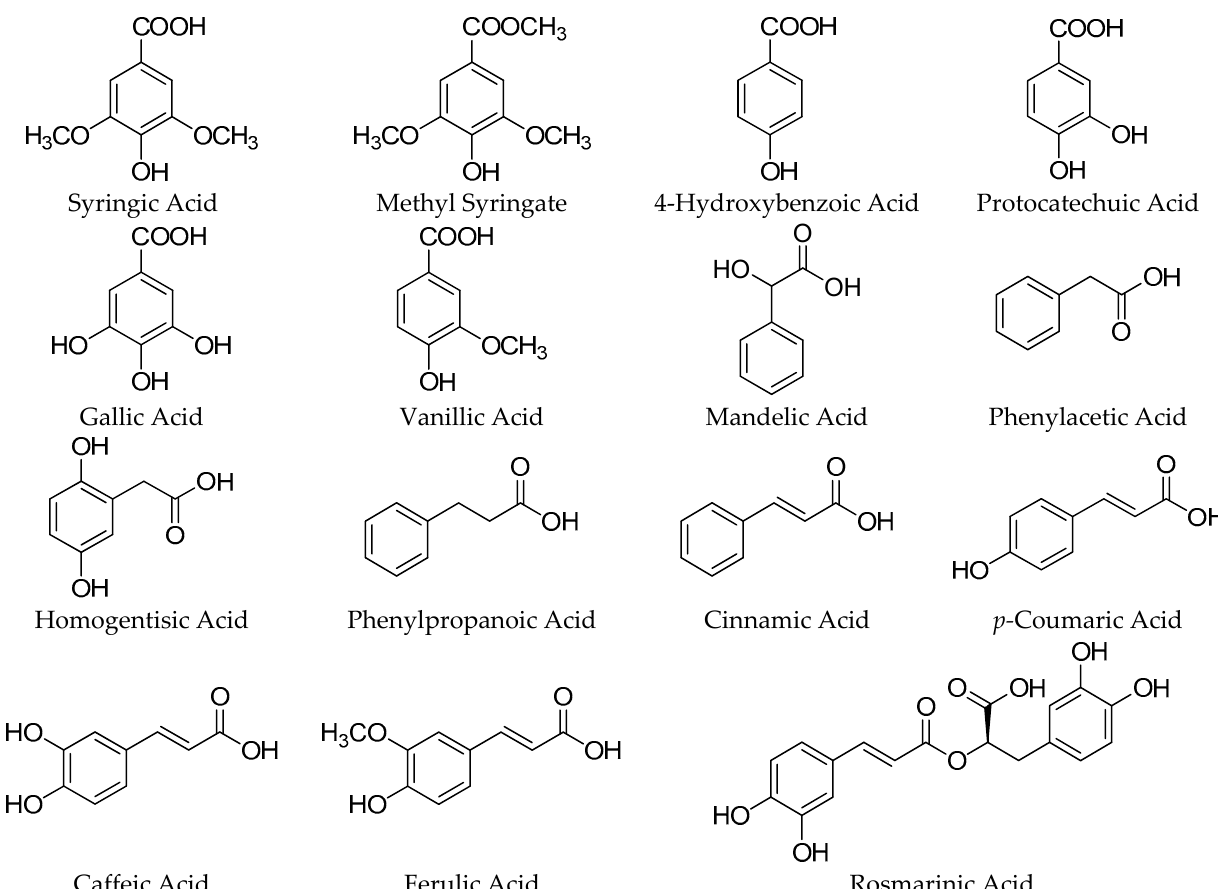
Figure 1. Phenolic acids and their derivatives in honey.